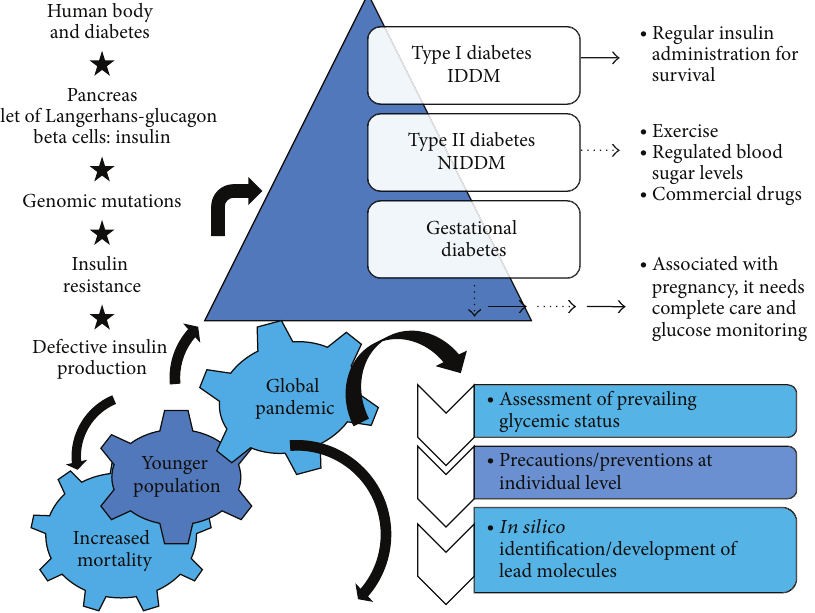
Figure 1: A schematic representation of general occurrence and approaches in diabetes